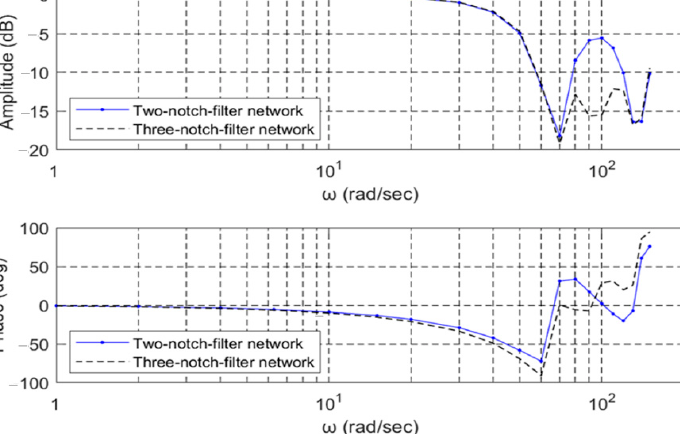
Figure 17. The bode plot of the notch filter networks.